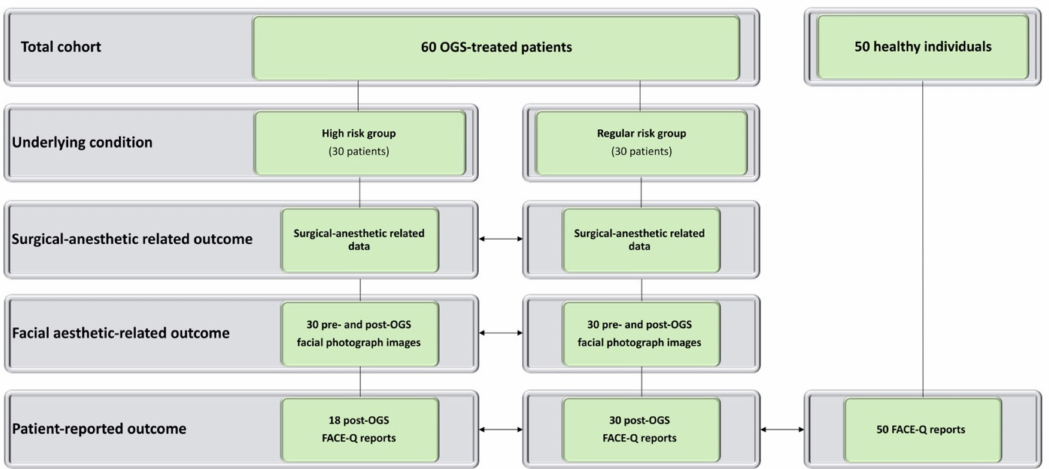
Figure 1. Flowchart for inclusion of orthognathic surgery (OGS)-treated patients with (high-risk patients) and without (regular-risk) underlying high-risk